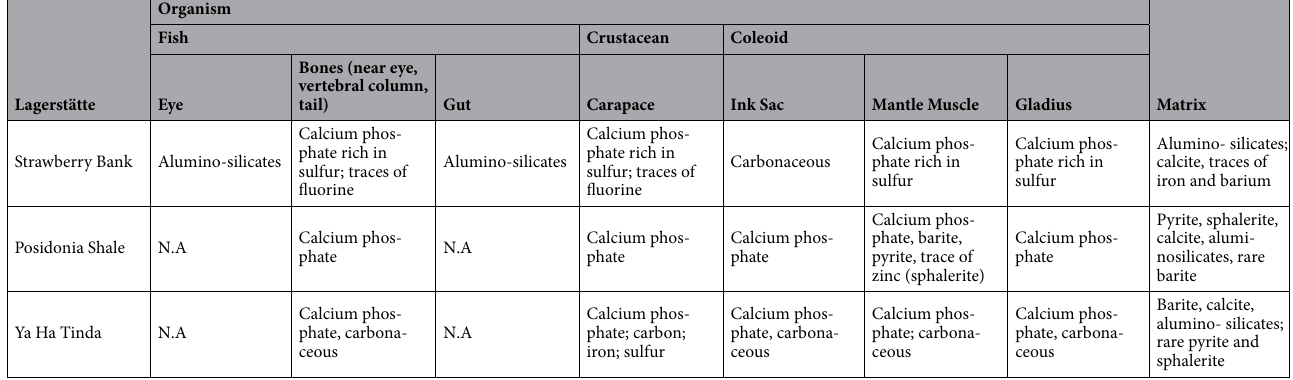
Table 2. Mineralogy of the analyzed